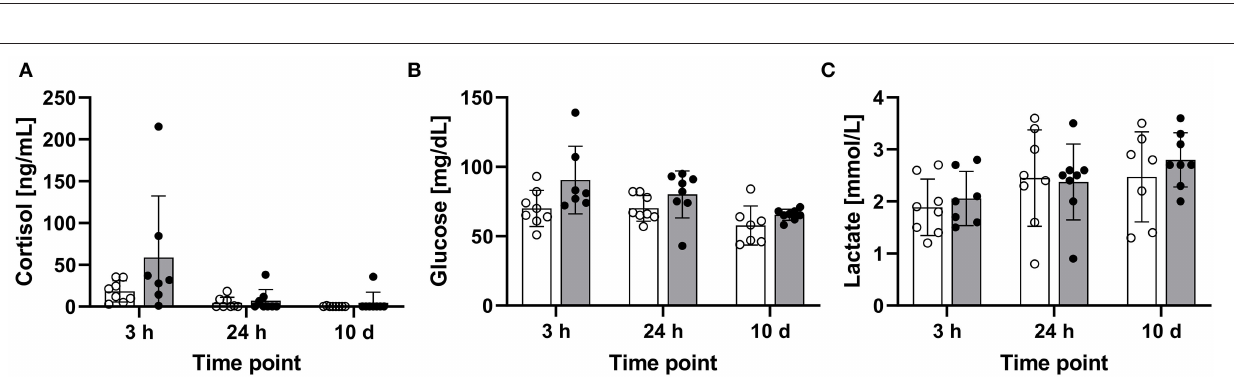
DMEM using a steel sieve (500 µ m). The resulting head-kidney cell suspension was then successively sieved through two cell strainers (200 and 100 µ m pore size). The sieved cell suspension was then layered onto an isotonic Percoll gradient ( ρ = 1.084 g/mL) and centrifuged at 800 × g for 30 min to reduce the number of erythrocytes. The cell band in the DMEM/Percoll interface was collected, washed, and resuspended in DMEM to obtain a final concentration of 20 million cells per mL. A 100 µ L sample of this cell suspension was incubated